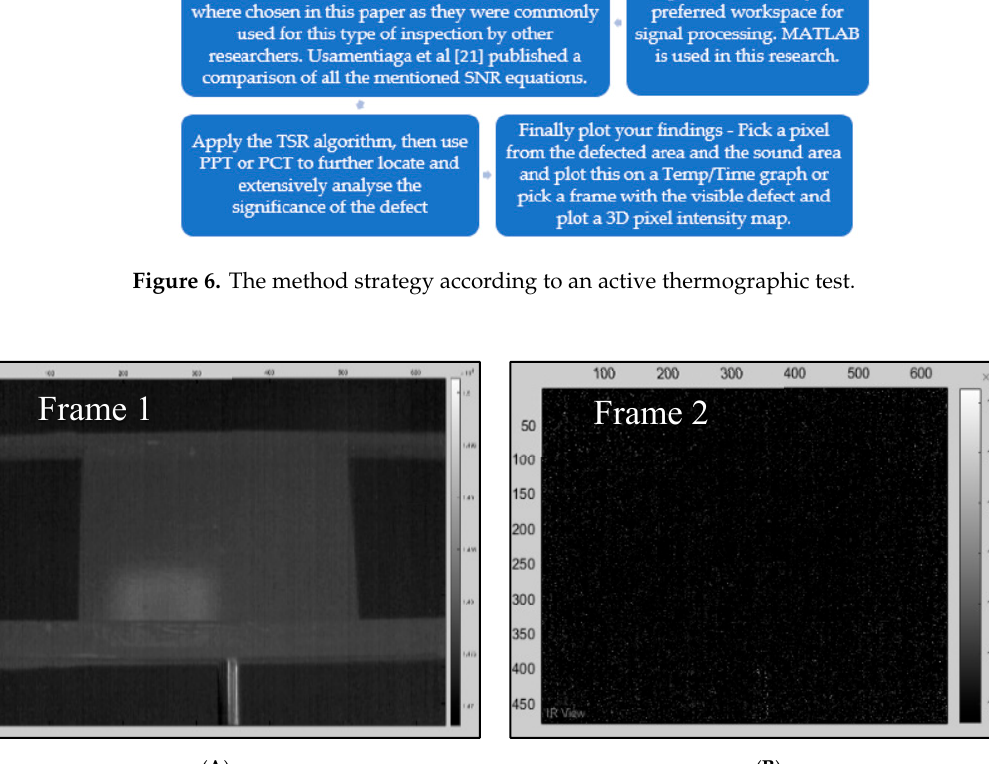
Figure 7. Dataset from sample 3.2, front surface, using the uncooled camera. ( A ) Reflection; ( B ) Post cold image subtraction, displaying just noise.